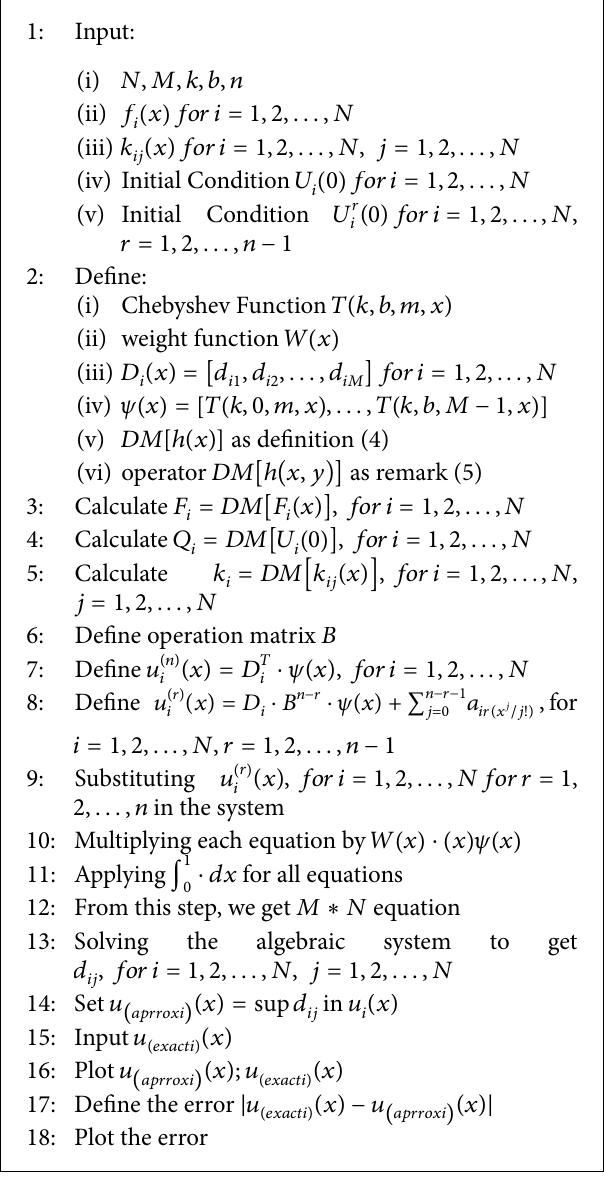
Algorithm 2: Numerical Realization Using the Chebyshev Wavelets